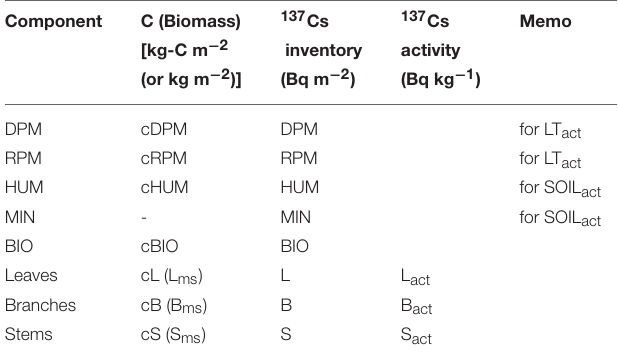
TABLE 2 | List of components and their abbreviations in the FoRothCs model.